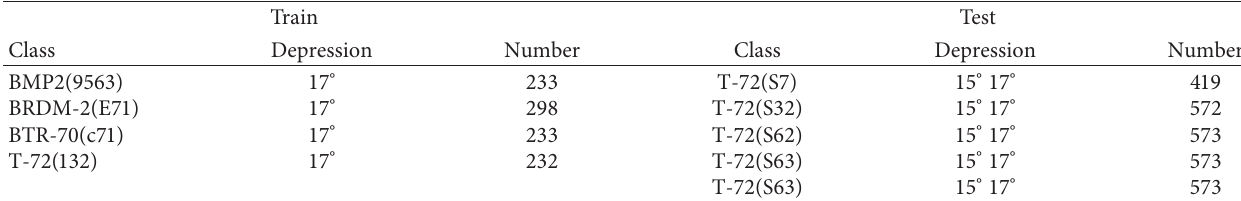
Table 2: Number of training and test samples for EOC-1 (configuration variants).